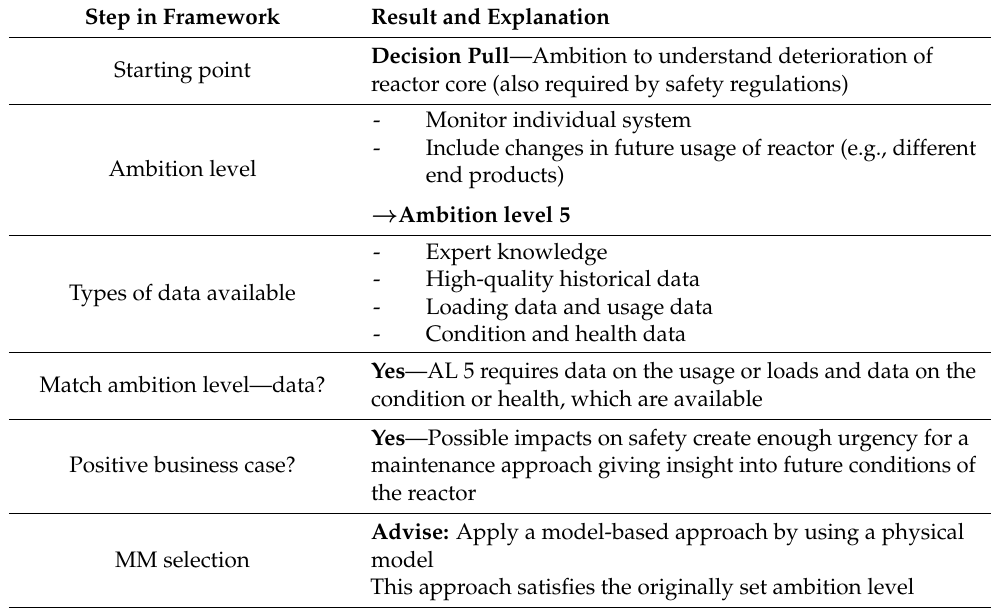
Table 4. Application of the decision framework to case